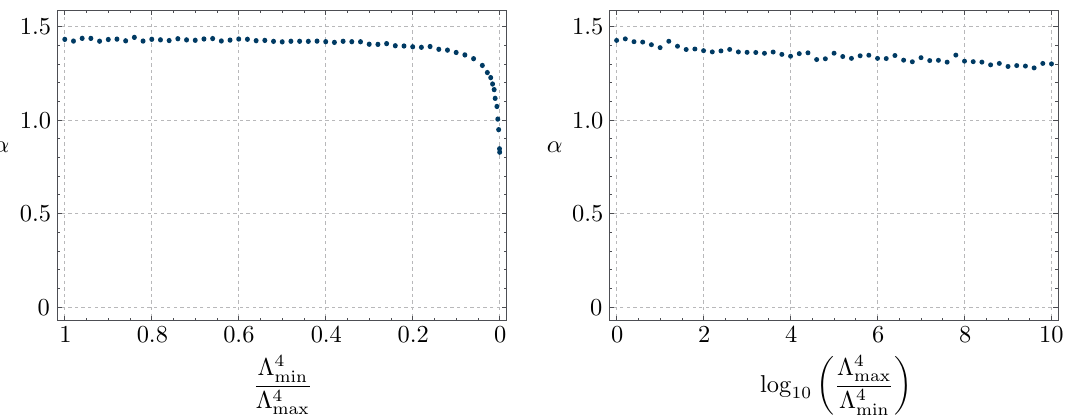
^ (cid:9) H with N , R ( H ) =f / are uniformly distributed over [(cid:3) 4 ; (cid:3) 4 ]. max min I